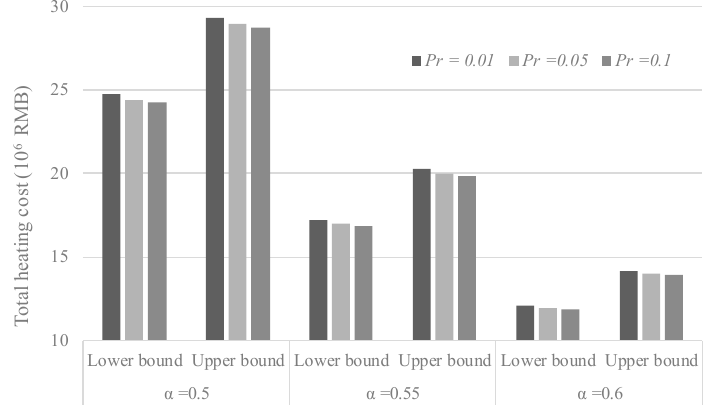
Figure 8. Total heating cost under different α and Pr values.